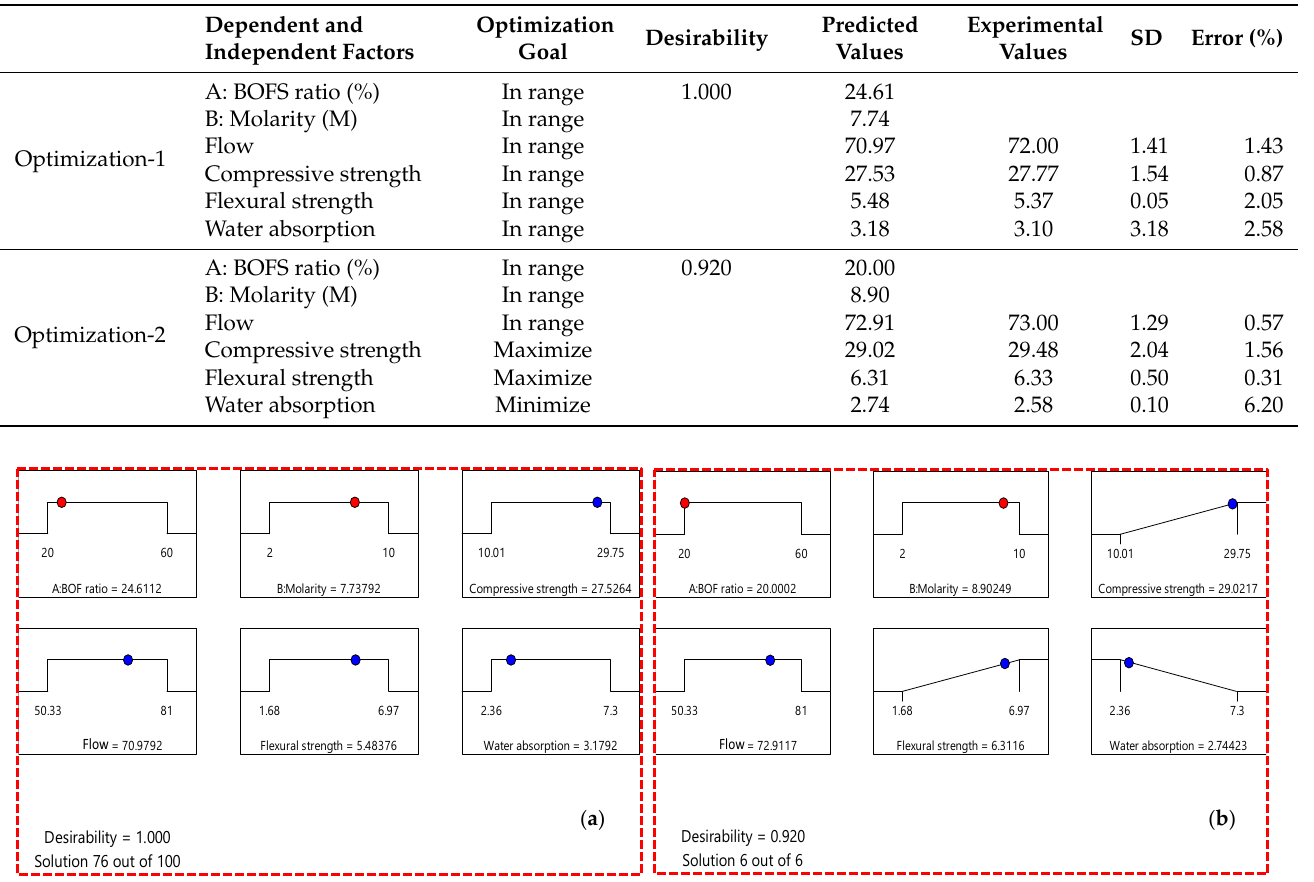
Figure 17. Ramp diagram of multi-objective optimization for ( a ) optimization-1 and ( b ) optimiza- tion-2.